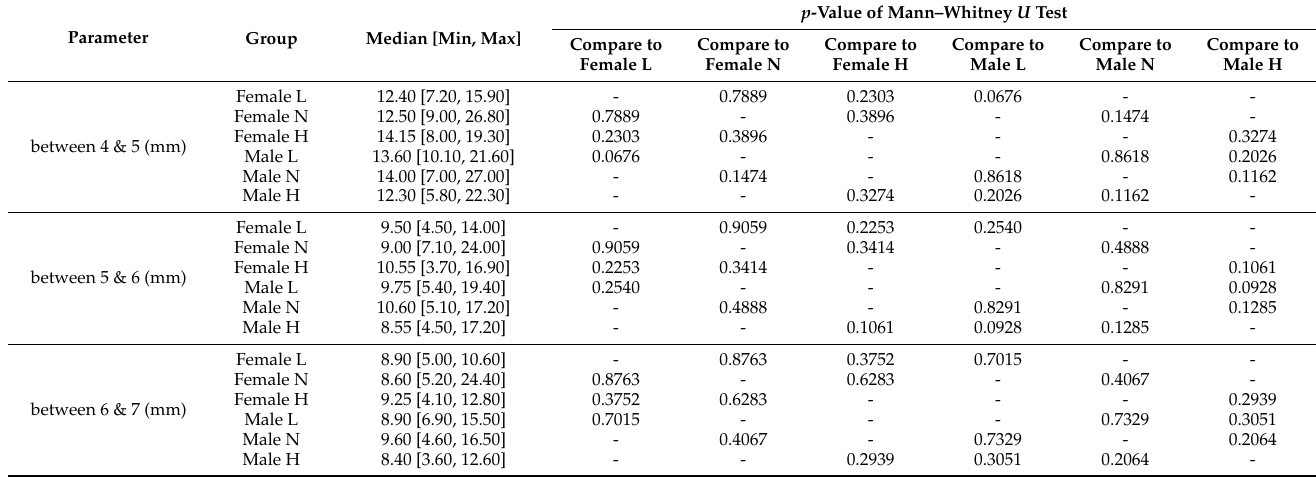
Table 4. The comparison of the alveolar bone height from the maxillary sinus floor to the alveolar bone crest among groups. L: low-angle; N: normo-angle; H: high-angle. 4: first premolar, 5: second premolar, 6: first molar, 7: second